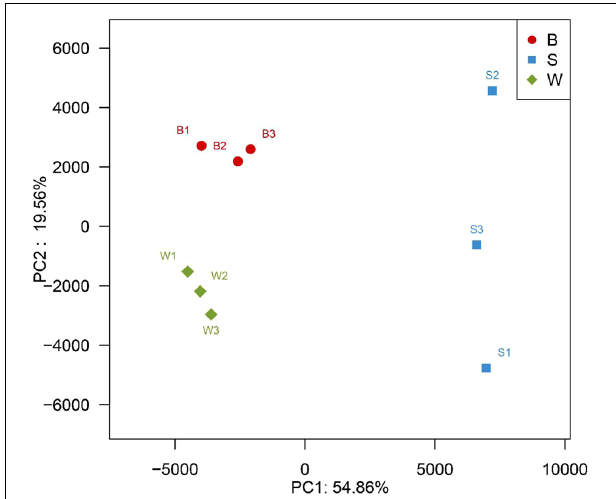
FIGURE 6 | Principal component analysis of nine metagenomes from three different types of starter made by two different processes, showing the relatedness of the bacterial community in the different samples.